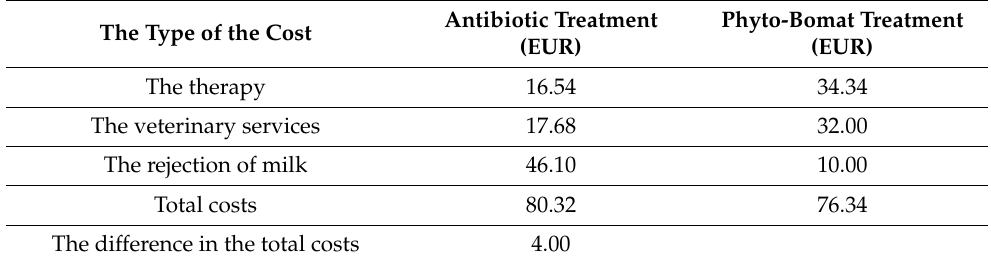
Table 6. The cost difference between antibiotic treatment and phytotherapy in euros (EUR).